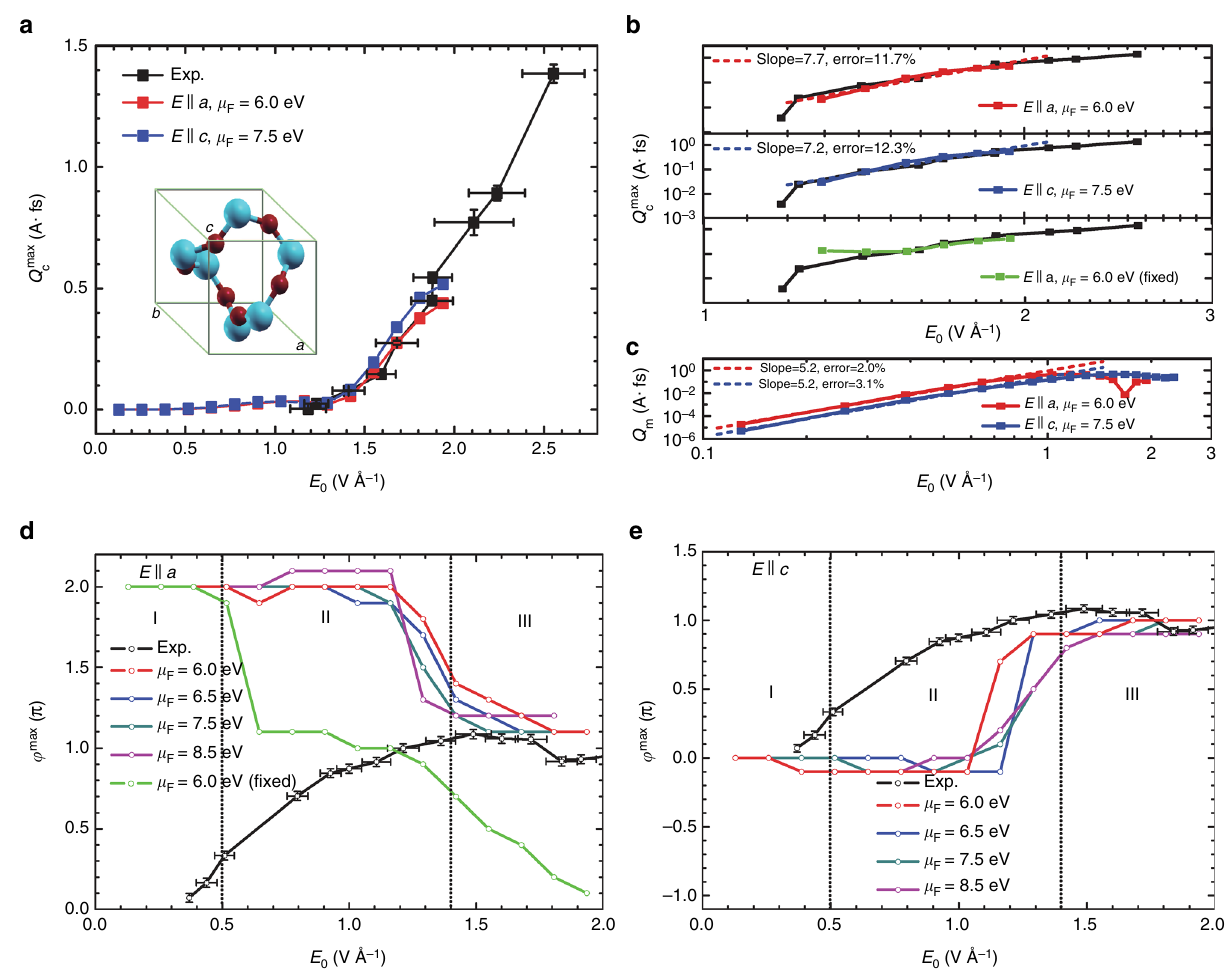
and the carrier envelope phase φ max required to induce it on the laser amplitude E 0 . a Fig. 4 Dependence of the maximum transferred charge Q max c Controllable Q max component of the response as a function of maximum laser amplitude for N = 6 junctions constructed along the a (red) and c (blue) c direction. The crystal structure of α -SiO 2 depicting the crystallographic directions is shown in the inset. To compare with experimental magnitudes 4 (black), simulation results are scaled by a cross-section η that accounts for the effective area of illumination by the laser pulse and differences in the optical response between fused silica and particular directions in alpha quartz [ η = 3.571× 10 5 unit cells (9.484 × 10 − 2 μ m 2 ) in the bc plane for E || a , and η = 2.632× 10 5 unit cells (5.503 × 10 − 2 μ m 2 ) in ab for E || c .]. b Log – log plots quantifying the power dependence of the simulated effect on the laser amplitude Q max